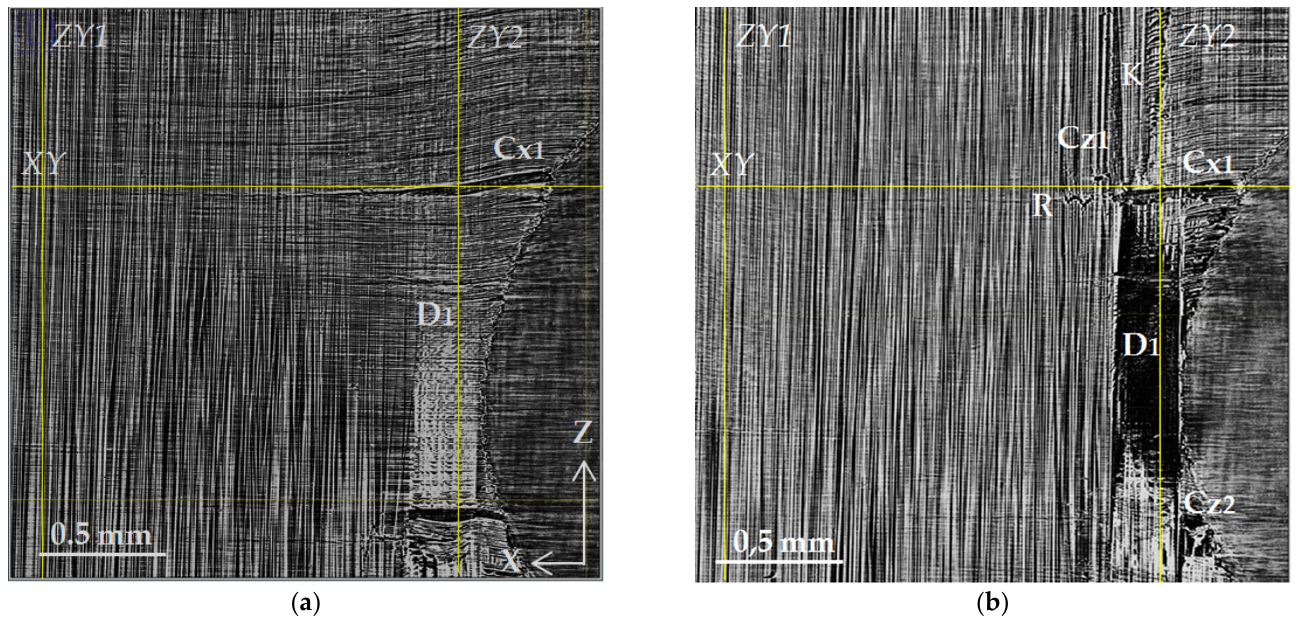
Figure 7. Magnified images of the damage zone D1: ( a ) layer presented in Figure 6b and ( b ) layer 25 µm deeper. D1 is interlayer delamination; Cx1—transverse crack spreading along the X-axis (90° fibers); Cz1 and Cz2—vertical cracks along the Z-axis (0° fibers); K—kinking of fibers; R—fiber rupture; XY—position of XY plane; ZY1 and ZY2—positions of YZ planes presented in Figures 8 and 9.